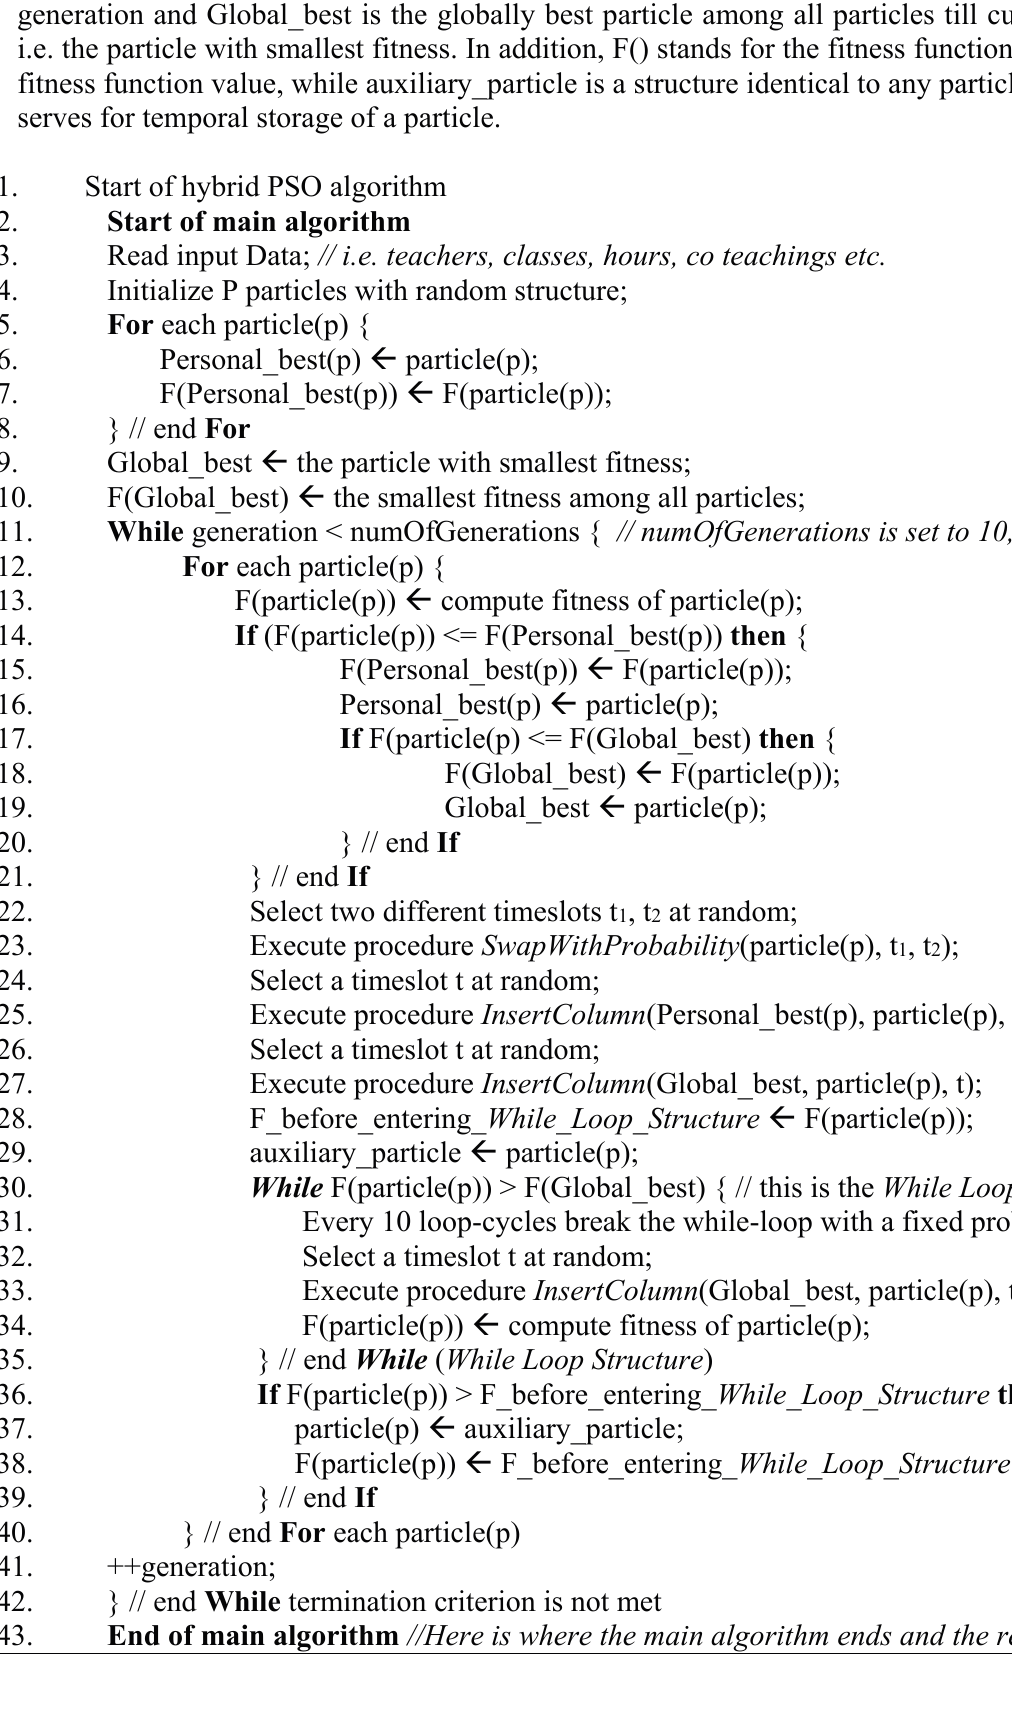
Algorithm 1: The pseudo code of the main PSO